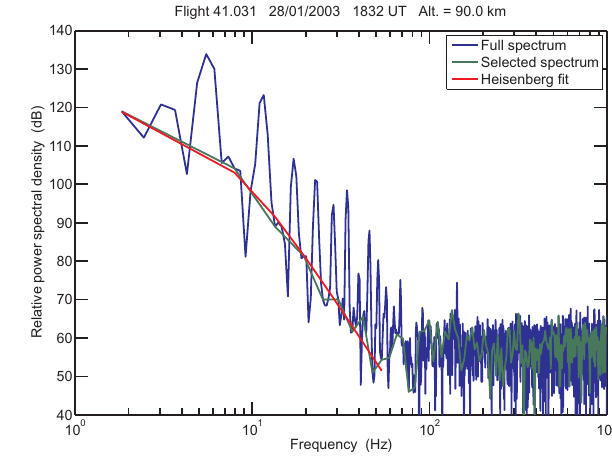
Fig. 9. An example from Flight 41.031 of the use of frequency domain filtering to reduce the effects of payload roll